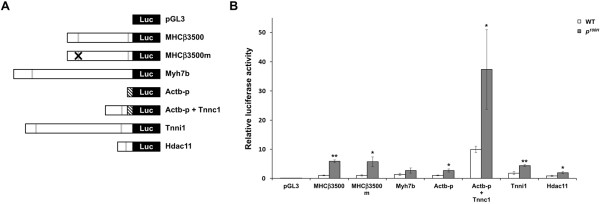
Differences of reporter activities between wild type and Sox6-null primary myotubes. A. Schematic representations of the firefly luciferase vectors constructed to test the function of Sox6 binding sequences. Black boxes indicate the firefly luciferase gene and shaded boxes indicate the chicken β-actin promoter (Actb-p). Open boxes indicate the upstream sequences of the wild type MyHC-β gene (MHCβ3500) or its mutated version (MHCβ3500 m; cross indicates mutation), Myh7b, Tnni1, and Hdac11, or the first intron sequence of Tnnc1. Approximate positions of Sox6 binding sites are indicated by gray lines. B. The reporter constructs shown in A were cotransfected with a Renilla luciferase vector into wild type (WT) and Sox6-null (p100H) primary myoblasts. After differentiation into myotubes, both luciferase activities were measured and normalized with Renilla luciferase activity. Data were further normalized to WT MHCβ3500 value (i.e. MHCβ3500 in WT = 1.0), and represented as mean ± SD (n = 3). (*) P < 0.05; (**) P < 0.005.